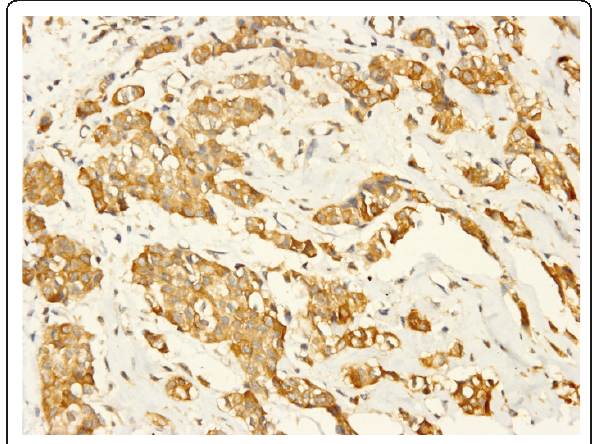
Figure 1 Higher power view of representative cytoplasmic immunostaining of XIAP in IDC . Original magnification for this figure: ×400.